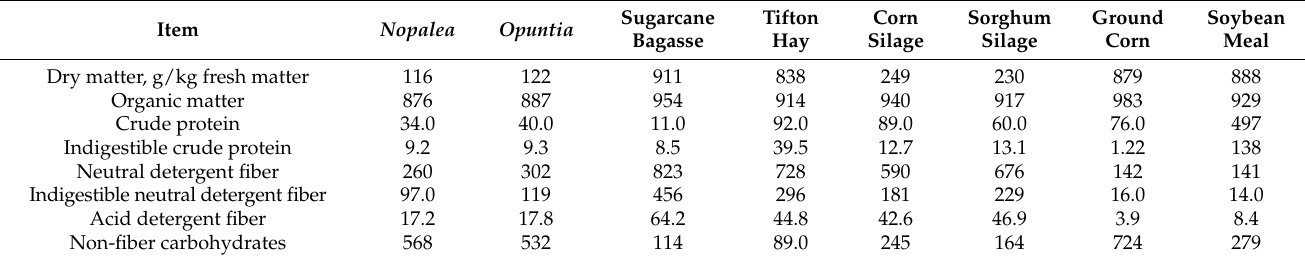
Table 1. Chemical composition of the ingredients used in the experimental diets (g/kg DM unless otherwise stated).